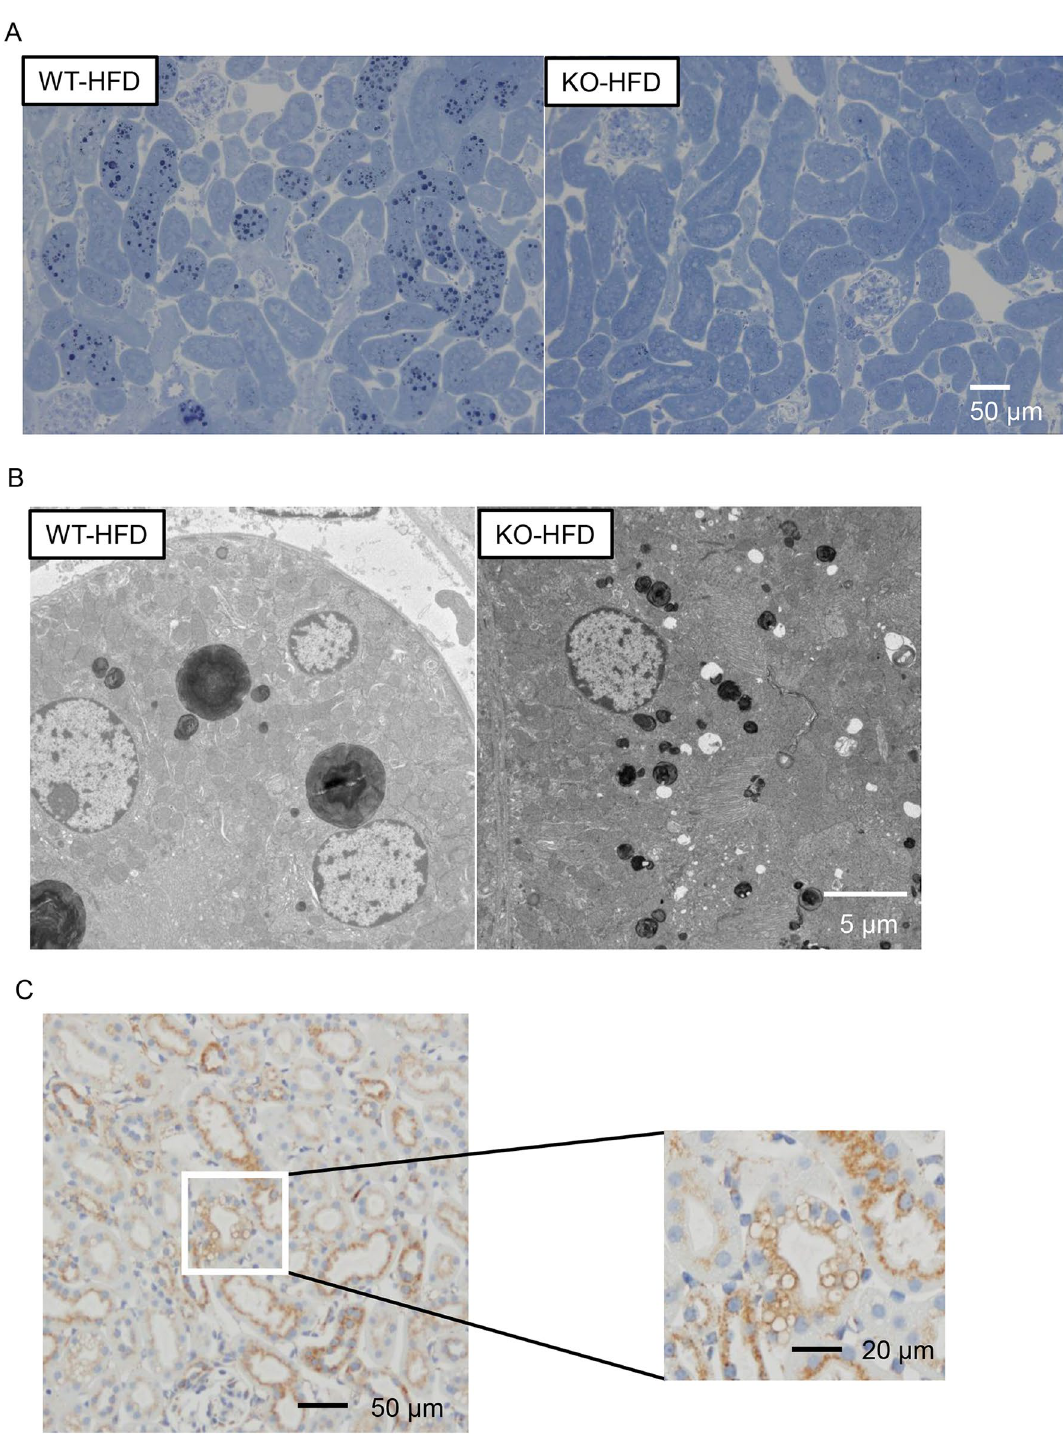
Figure 4. Vacuolation in the proximal tubules of WT-HFD and KO-HFD mice. ( A ) Toluidine blue staining (200 ×, scale bar: 50 µm) and ( B ) electron microscopy of the proximal tubules (1200 ×, scale bar: 5 µm). Aggregation with strong toluidine blue staining is observed in some proximal tubules in the WT-HFD group, whereas the aggregation is rarely observed in the KO-HFD group. Electron-dense multilamellar whirl structures are present in the cytoplasm of tubules in both groups. The accumulation is more extensive in the WT-HFD group than in the KO-HFD group. ( C ) Immunohistochemical staining for LAMP1 in the proximal tubules of the WT-HFD group shows that LAMP1 surrounds vacuolar membranes (200 × , scale bar: 50